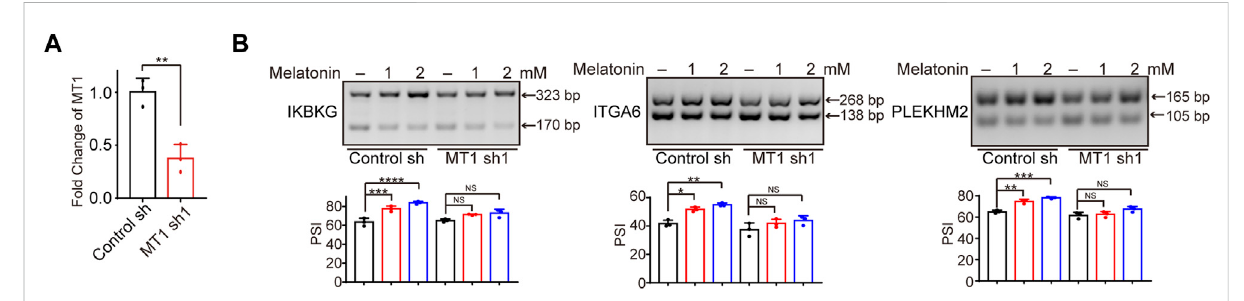
FIGURE 5 The regulatory effect of melatonin on alternative splicing is dependent on MT1. (A) The MT1 expression was validated by RT-qPCR. (B) Exons skipping of IKBKG , ITGA6 , and PLEKHM2 were examined by semi-quantitative RT-PCR in control and MT1-konckdown HepG2 cells treated with 1mM and 2 mM melatonin for 24 h. The mean ± SD of PSIs from three experiments were plotted and p values calculated by one-way